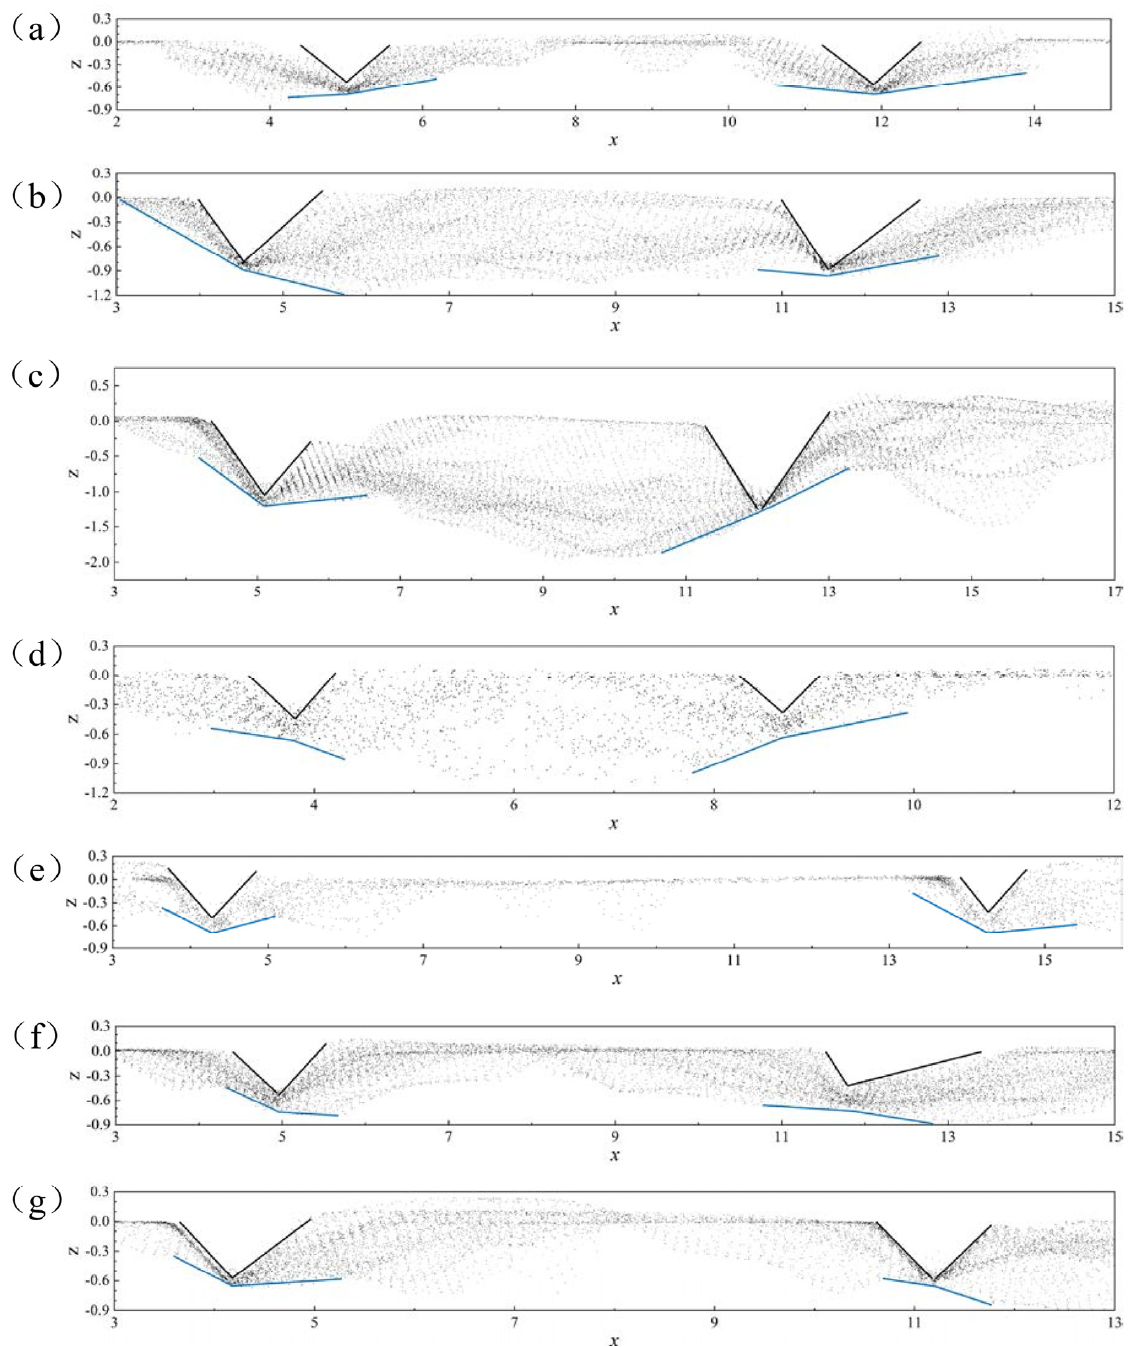
Figure 11. Front view of the specimen pressed into damage with different shear indenters. ( a ) Shear indenter 1 ( b ) Shear indenter 2 ( c ) Shear indenter 3 ( d ) Shear indenter 4 ( e ) Shear indenter 5 ( f ) Shear indenter 6 ( g ) Shear indenter 7. Table 4. Angle of tooth mark statistics. Minimum Damage Angle ( β min )/(°) Maximum Damage Angle ( β max )/(°) NO. Left Right Left